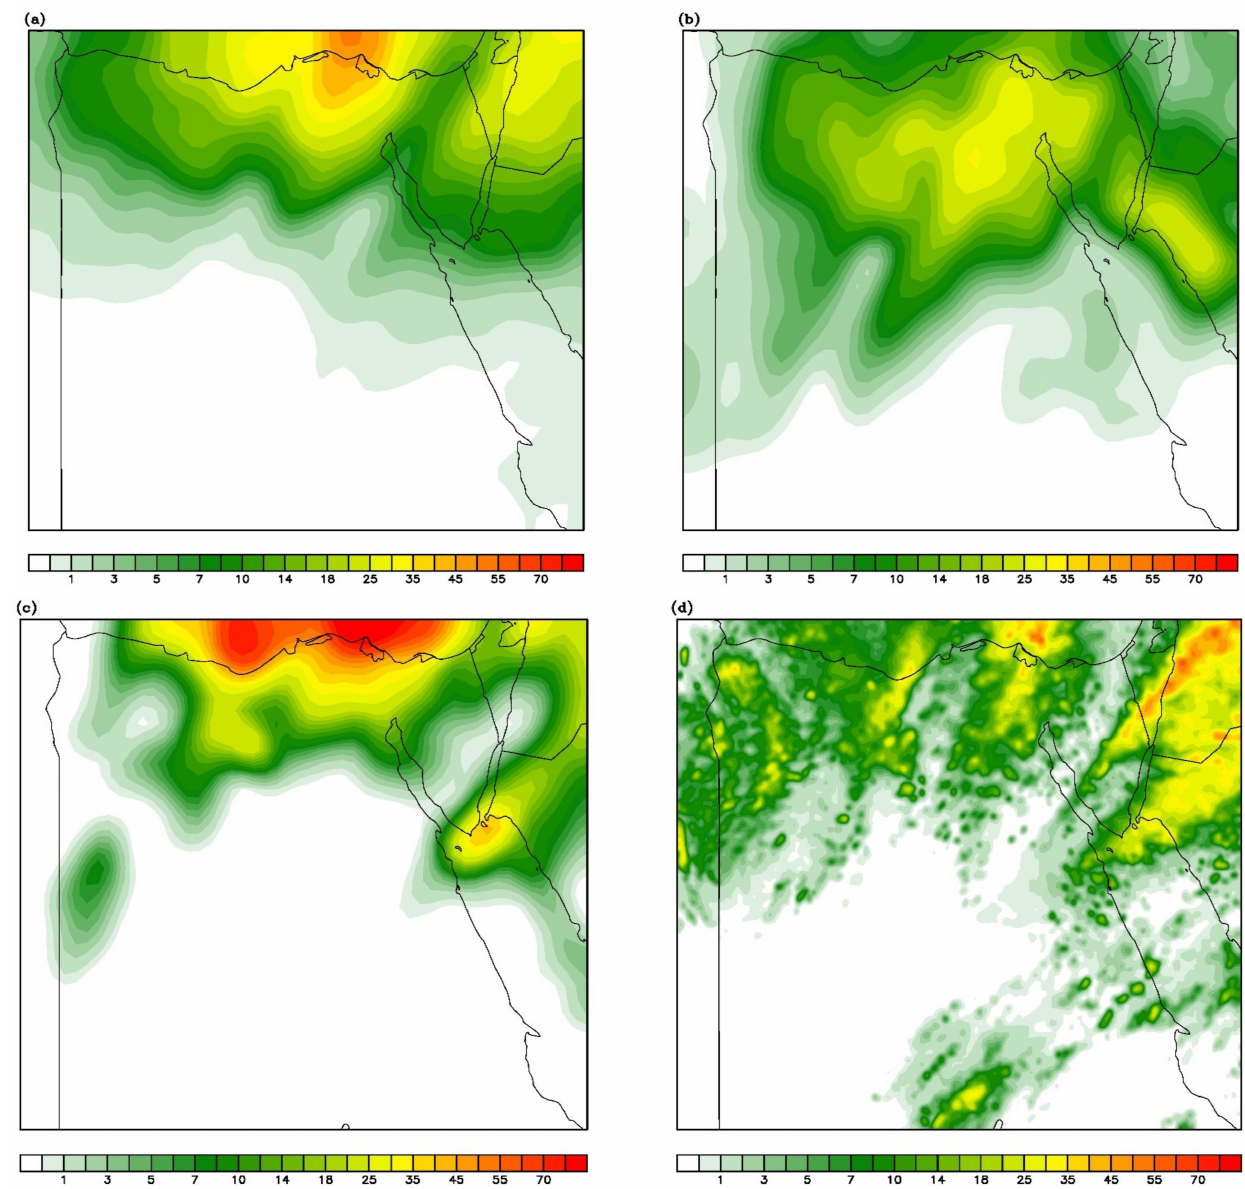
Figure 3. 24 h accumulated rainfall amount on 12 March 2020 according to ( a ) PERSIANN-CDR, ( b ) ERA5, ( c ) CMORPH and ( d )